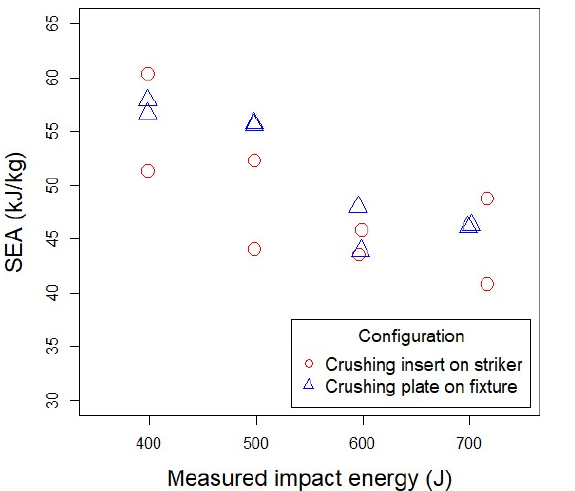
Figure 10: Peak force during the test as a function of the impact energy with constant falling mass of 60.2 kg.